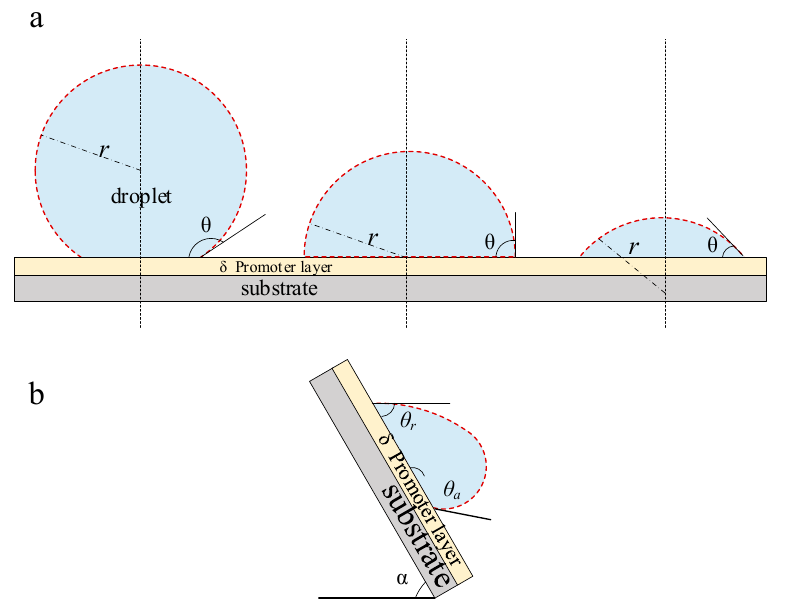
Figure 1. The contact angle of the droplets on different surfaces: ( a ) surface contact angle; ( b ) advancing contact angle and receding contact angle.